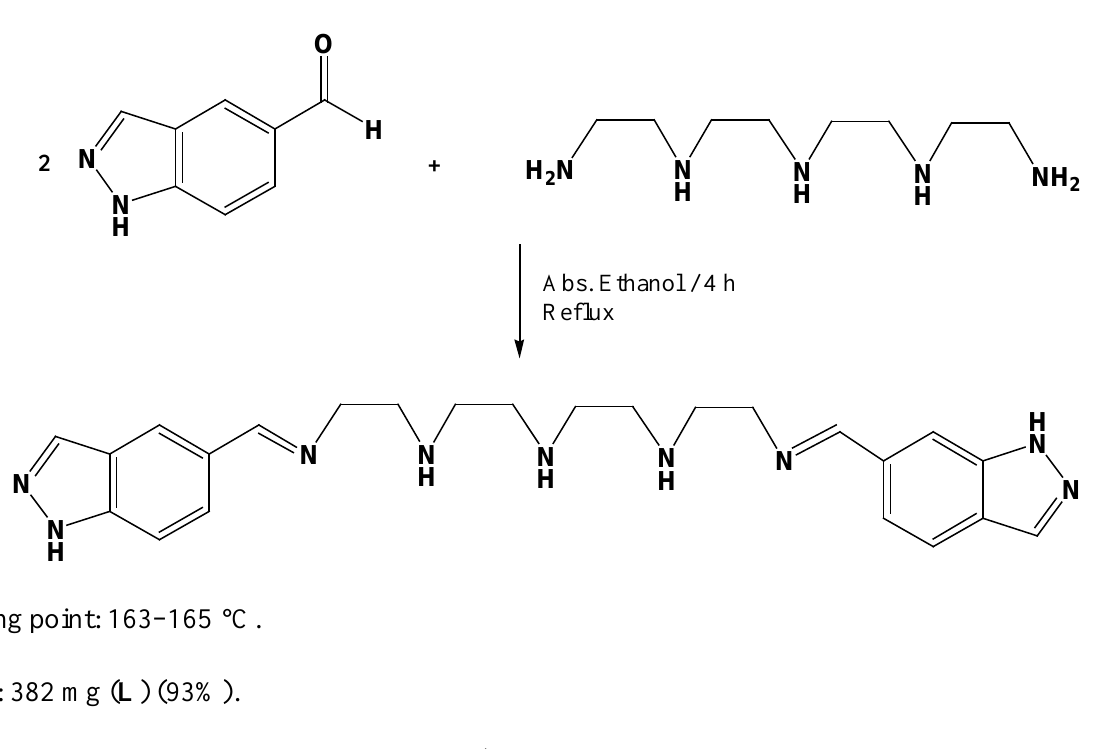
Scheme 1. Schematic representation of compound L